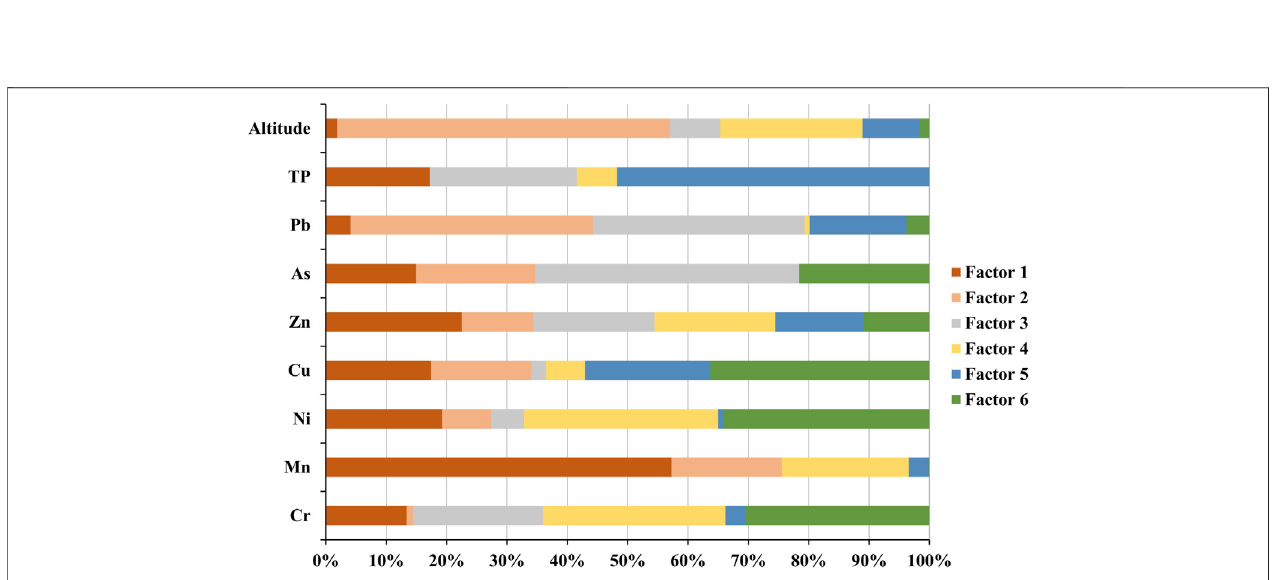
FIGURE 6 | Heavy metal factor fi ngerprints in Lushan scenic